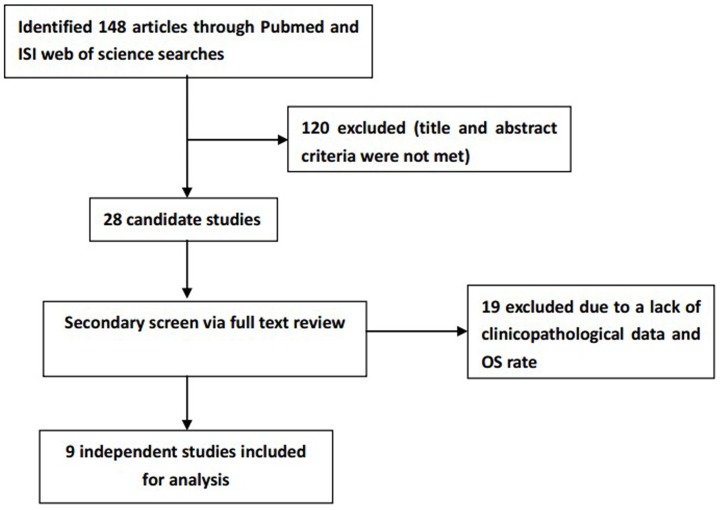
Flow chart for the selection of articles to include.